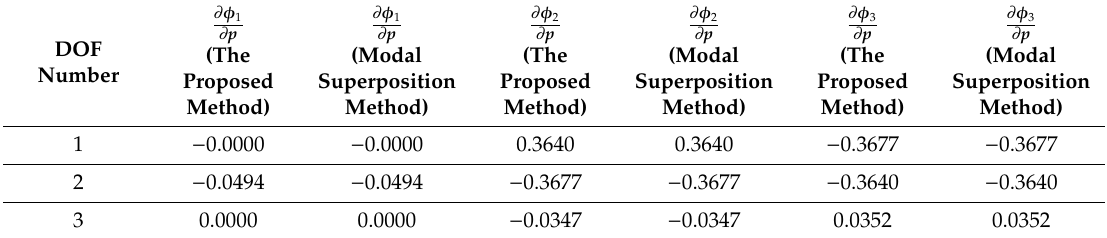
Table 3. Eigenvector sensitivities obtained by the proposed method and the modal superposition method.